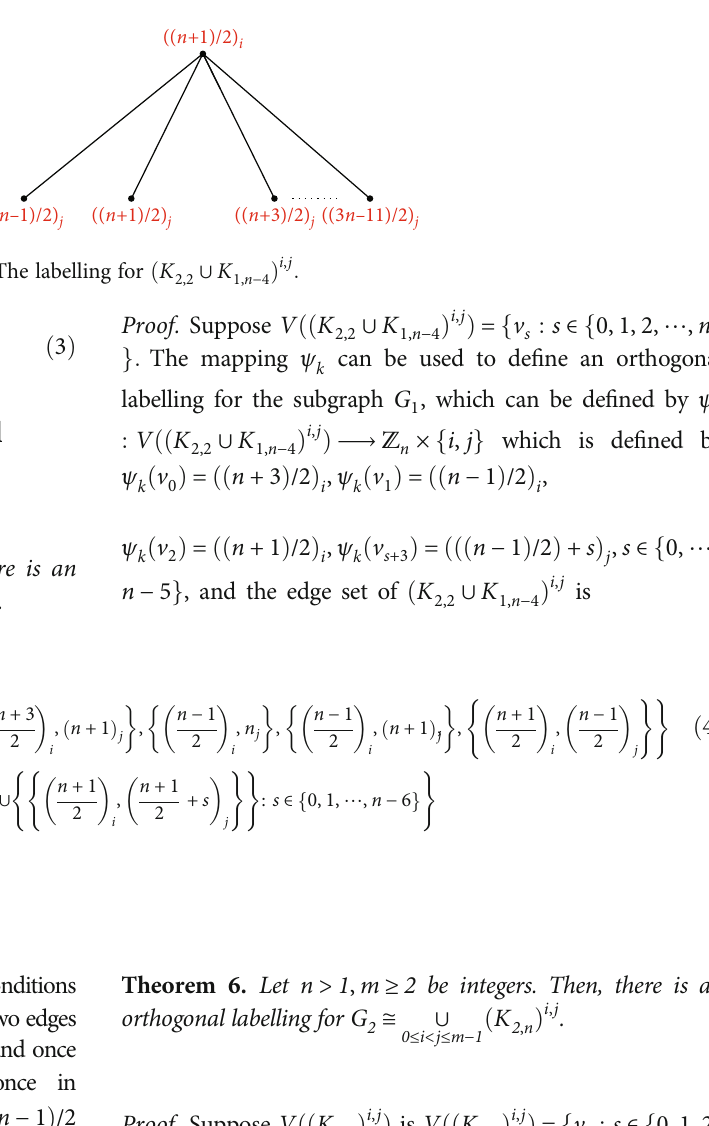
Figure 3: An edge decomposition of K